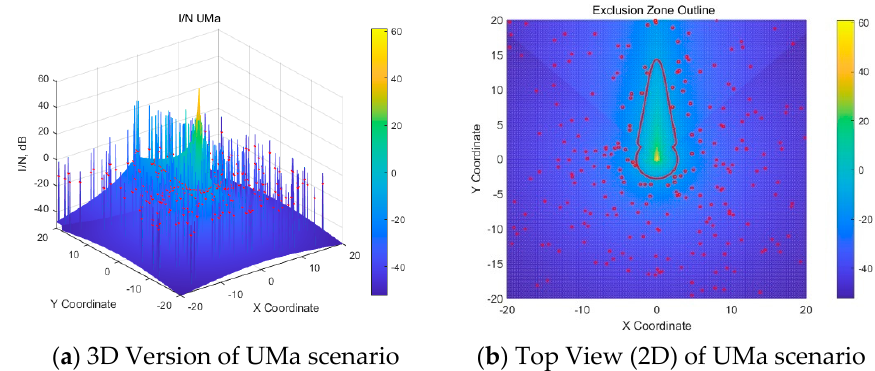
Figure 11. UMa scenario with ES antenna elevation angle of 5°.